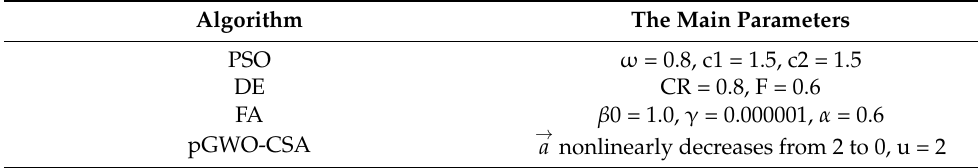
Table 2. Main parameters of the four algorithms. Algorithm